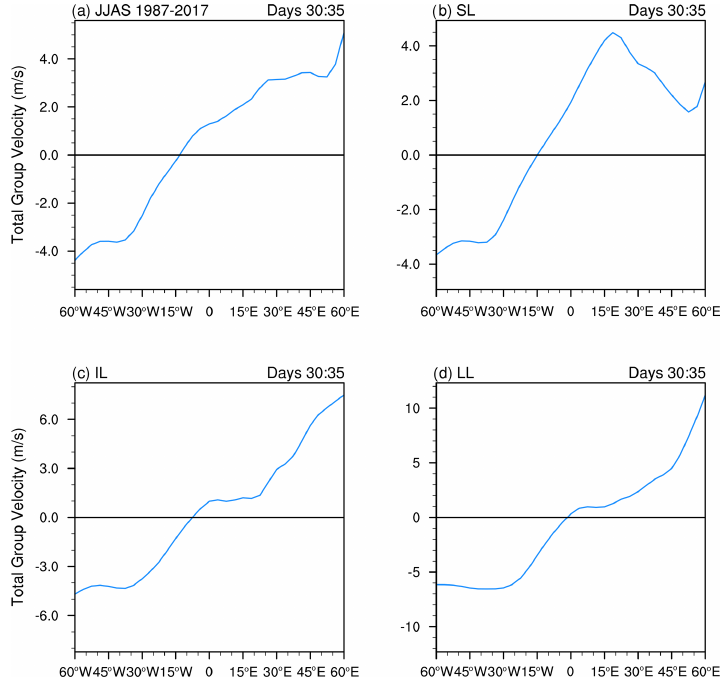
Figure 13. Total group velocity (ms − 1 ) averaged over days 30–35 of the simulation for the four basic states as marked on the panel: (a) the JJAS long-term climatology, (b) short-lived (SL), (c) intermediate-lived (IL), and (d) long-lived (LL). C g is evaluated from Eq. (9), integrated over half-wavelengths in the zonal direction, from − 5 to 30 ◦ N meridionally, throughout the model depth in the vertical direction.